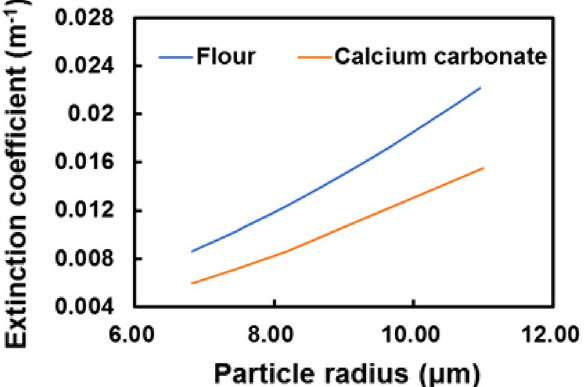
Figure 8. Extinction coefficient simulation for flour and calcium carbonate. The flour density is set to 600 kg m −3 and calcium carbonate density is 2600 kg m −3 . The extinction coefficient of flour is larger than that of calcium carbonate because the number of flour particles released is larger than that of calcium carbonate.